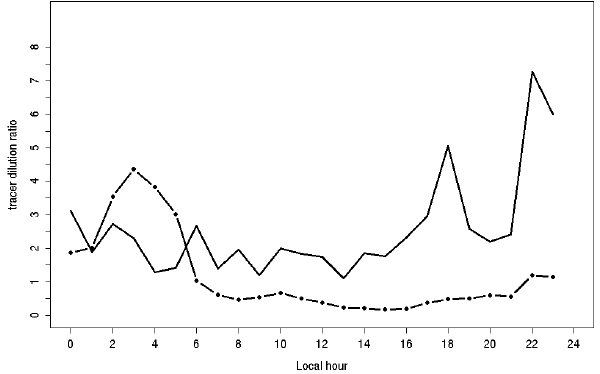
Figure 17: Evolution of the volcanic passive tracer dilution ratio at Piton Maïdo in 1/1000’s 2 of the concentration at emission point PDF (solid line: ALIZ10, dashed line: ALIZ5). 3 Fig. 17. Evolution of the volcanic passive tracer dilution ratio at Piton Ma¨ıdo in 1/1000’s of the concentration at emission point PDF (solid line: ALIZ10, dashed line: